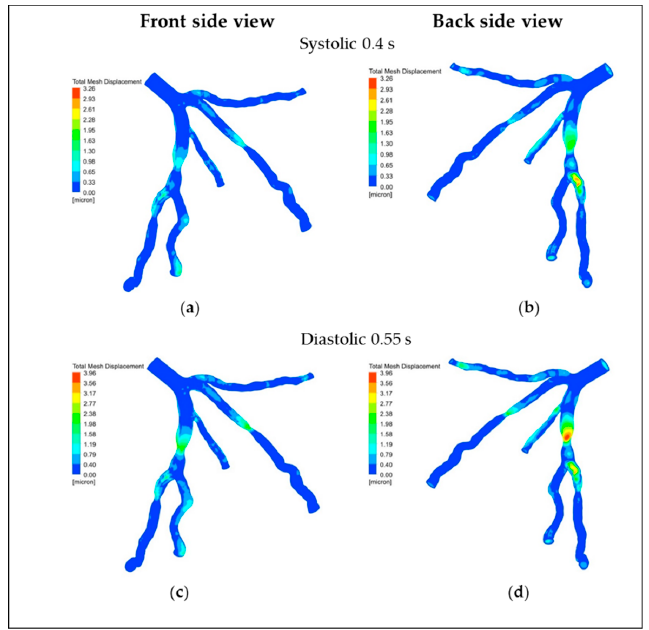
Figure 8. Projected displacement patterns on wall of left coronary artery (LCA) at systolic flow for different views—( a ) front side ( b ) back side, and diastolic flow ( c ) front side ( d ) back side.